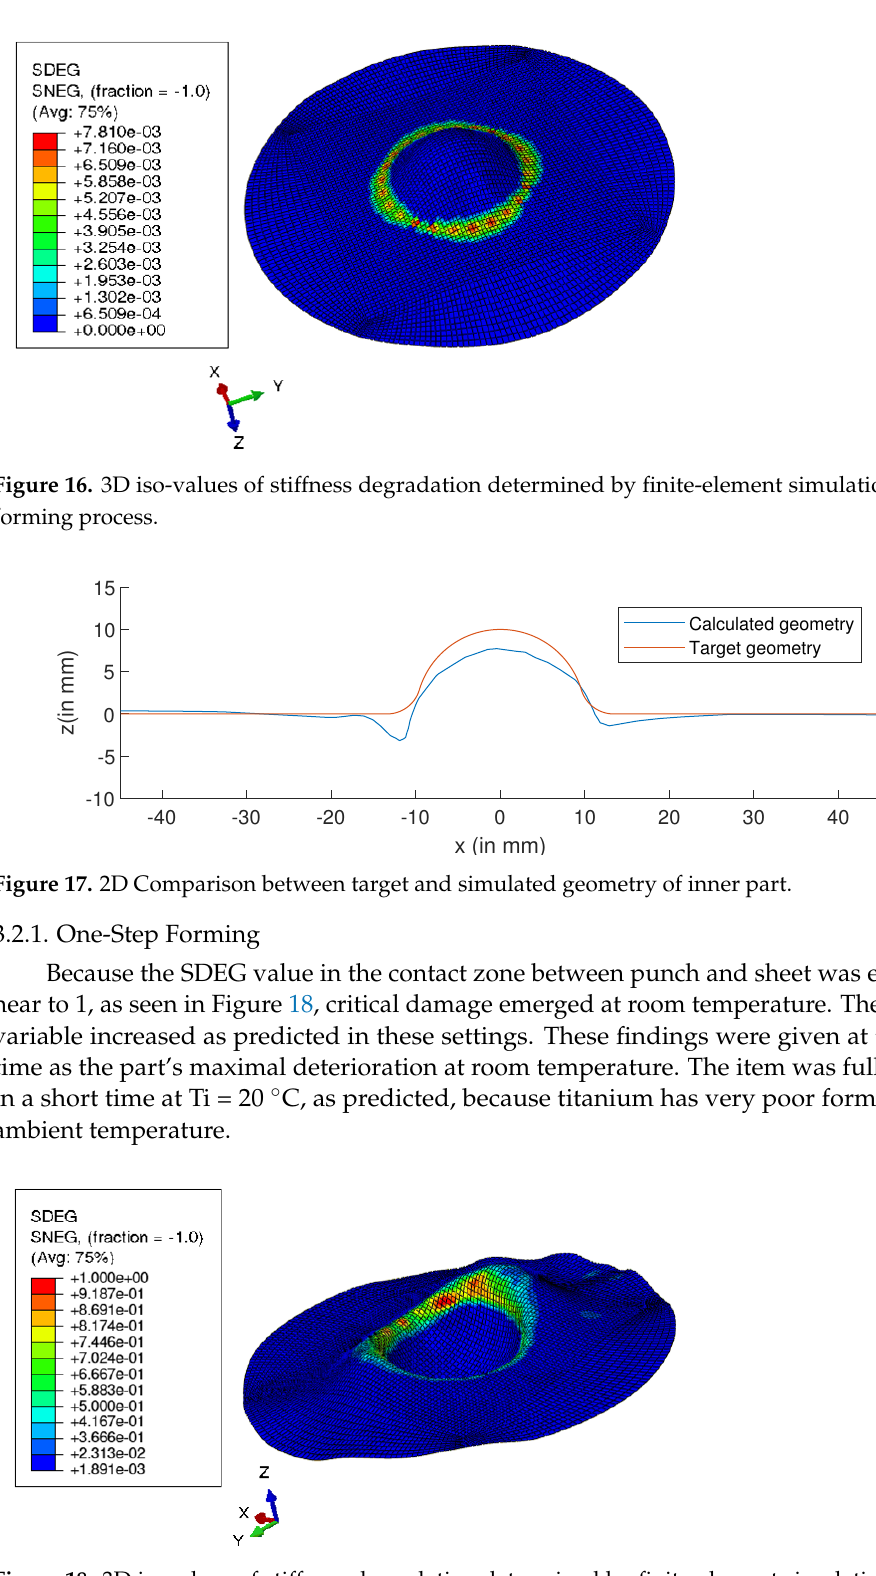
Figure 18. 3D isovalues of stiffness degradation determined by finite-element simulation for one- step